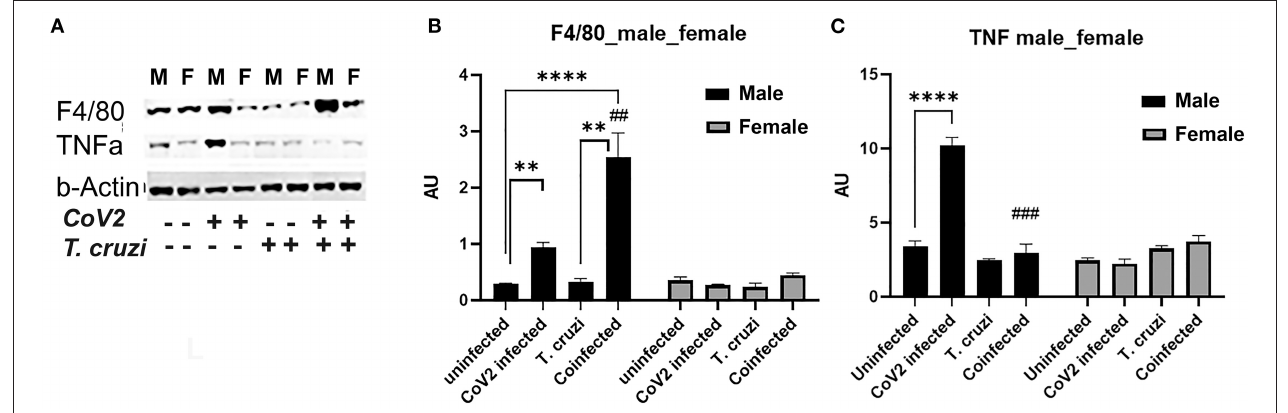
FIGURE 6 | Immunoblot analysis of inflammatory markers in the hearts of CoV2 infected, T. cruzi infected, and coinfected huACE2 mice. Western blot images (A) of macrophage marker (F4/80) and proinflammatory cytokine TNF α . β -Actin was used as loading control. Fold changes in the protein levels of F4/80 (B) and TNF α (C) were normalized to β -Actin expression and are shown as bar graphs (A dot plot displaying individual data point presented in Supplementary Figure 4 ). The error bars represent standard error of the mean. ** p < 0.01 and **** p < 0.0001 compared to uninfected sex matched mice ( n = 4/sex/group). ( ## p ≤ 0.01, and ### p ≤ 0.001 for comparisons between CoV2 infected and coinfected mice) (M, male; F,